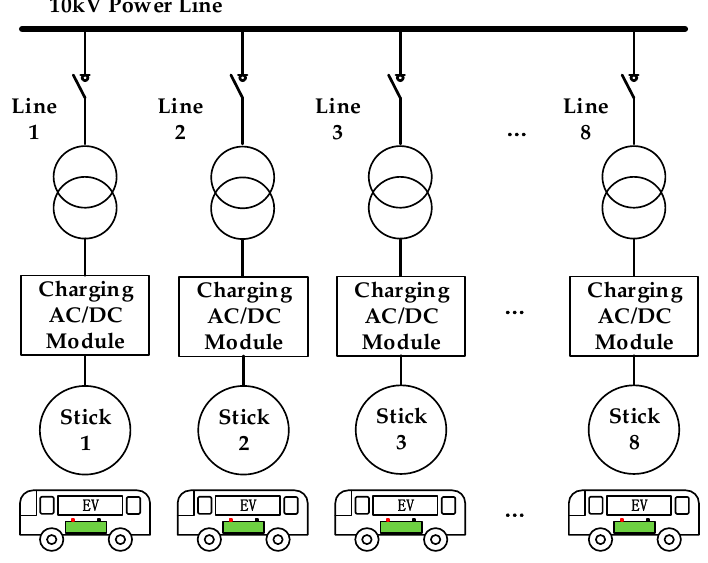
Figure 1. Charging topology of the direct current (DC) fast-charging station.